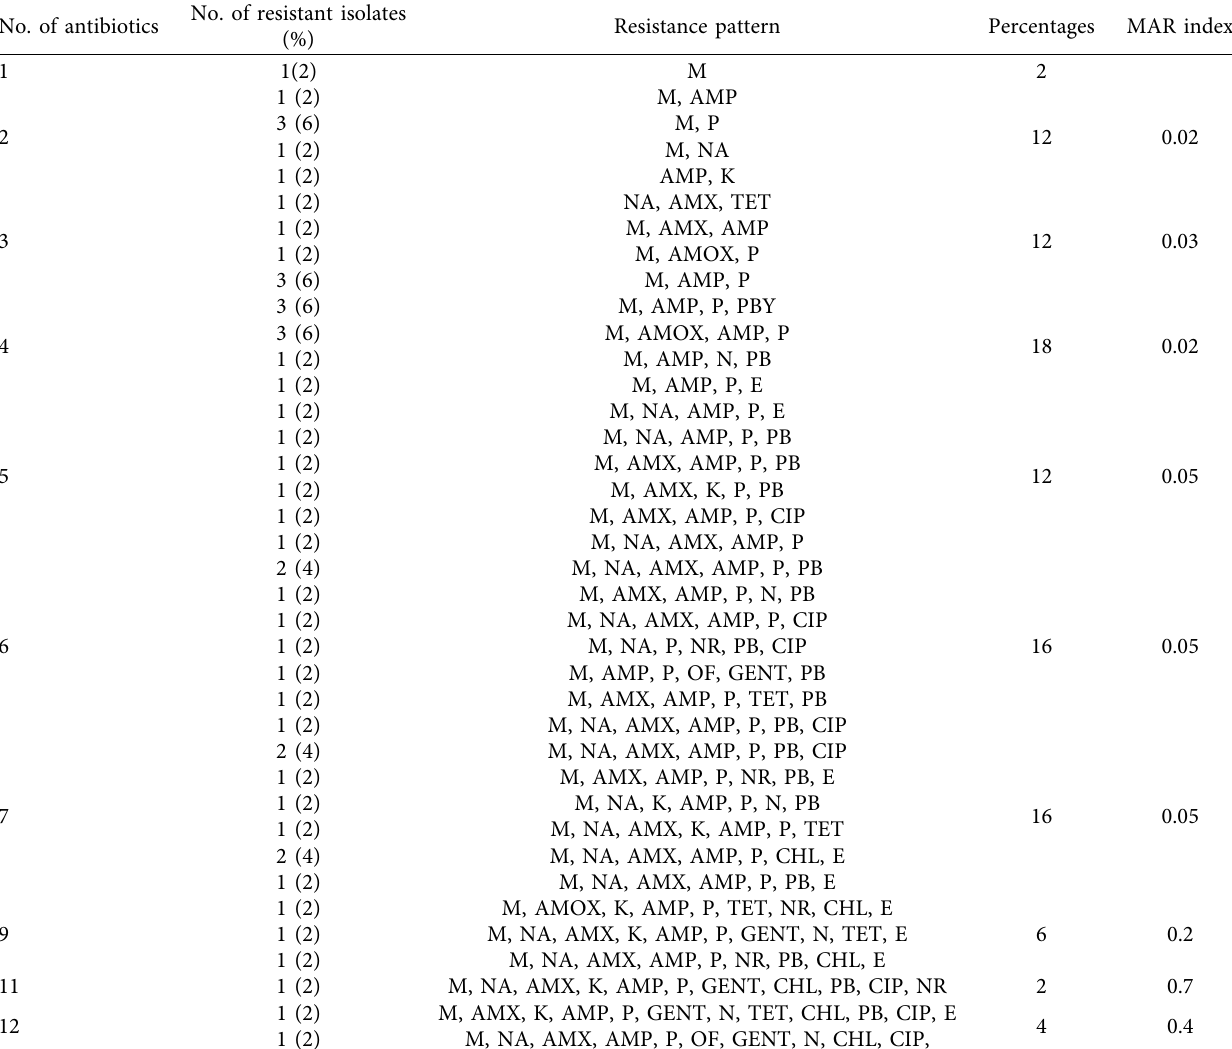
Table 5: Antibiotic resistance patterns in P. vulgaris ( n � 50) from the hospital wastewater.